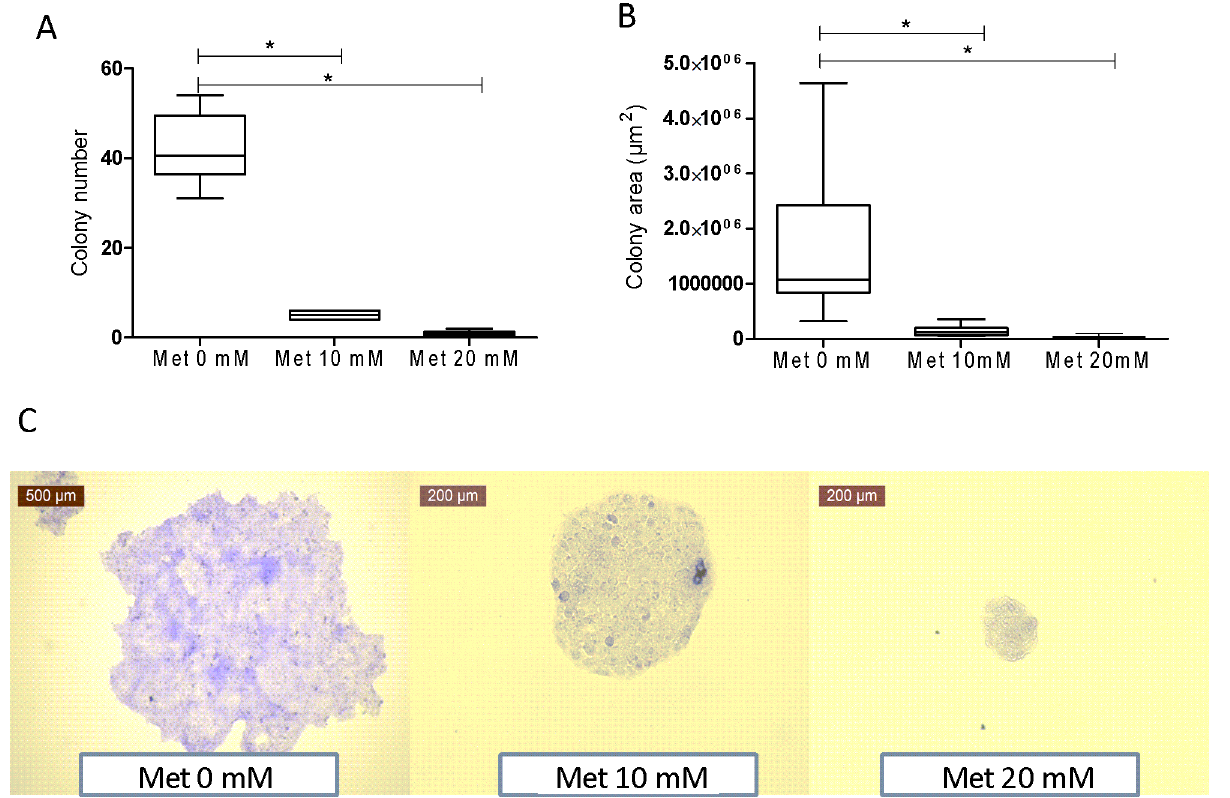
Fig 1. Metformin inhibits HaCaT cell proliferation and colony formation. 1000 cells/well human HaCaT cells were plated onto 6-well and incubated at 37°C with 5% CO 2 . After 24h, the culture medium was replaced with fresh culture medium containing 0.0 mM, 10 mM or 20 mM every 3 days for 9 days. (A) At 9 days the cells colonies were stained and counted as described in the methods section. (B) Colony area was determined using Image J program. (C) Image is representative of the size of colonies observed for each of the treatments. Data are representative of six independent